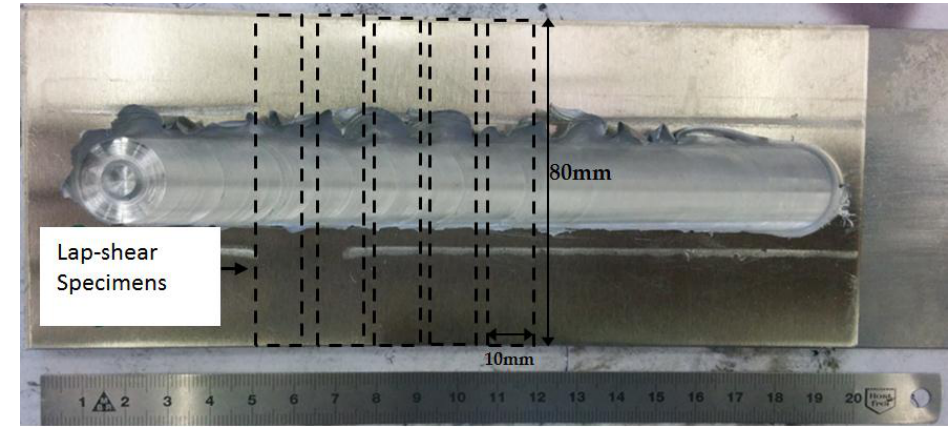
Figure 4. Five tensile shear specimens cut from the same joint.